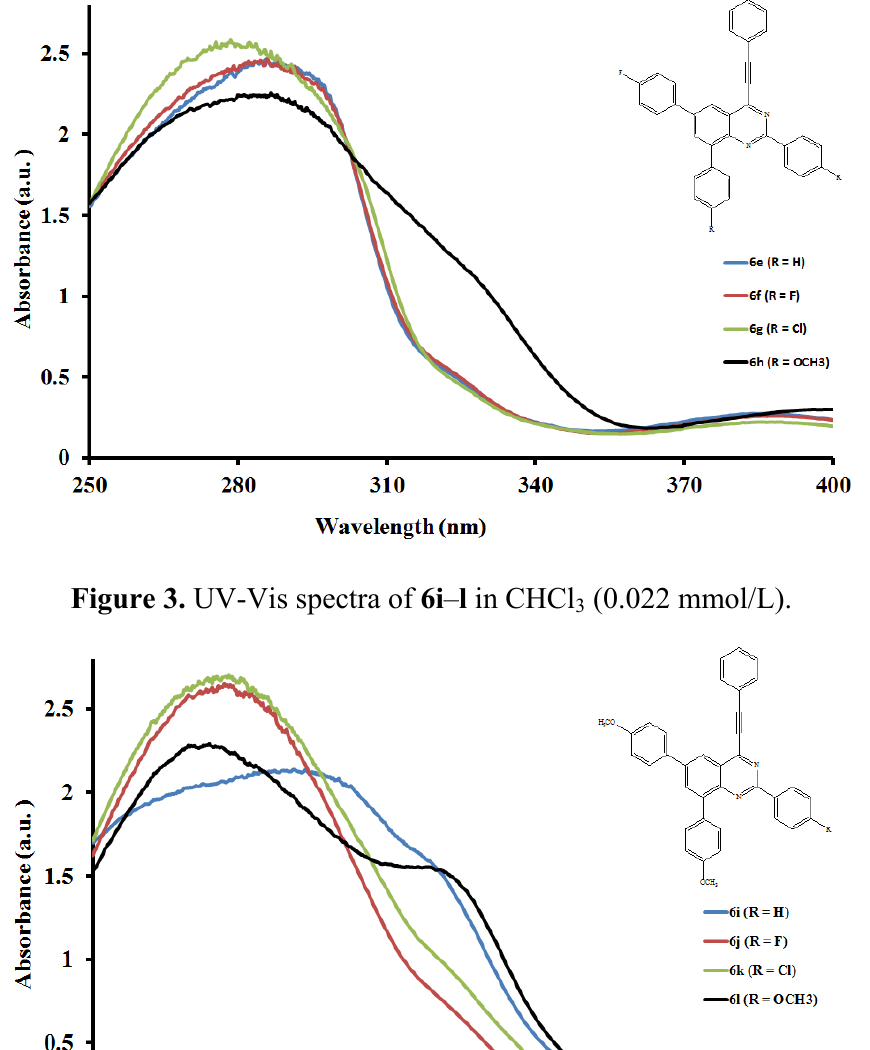
Figure 2. UV-Vis spectra of 6e – h in CHCl